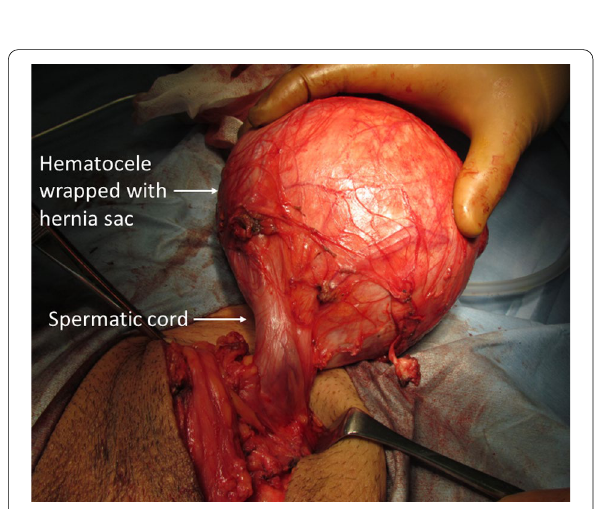
Fig. 4 Intraoperative findings during the second operation. A giant hematocele 13 cm in diameter wrapped with a hernia sac was tightly adherent to the spermatic cord and testicles